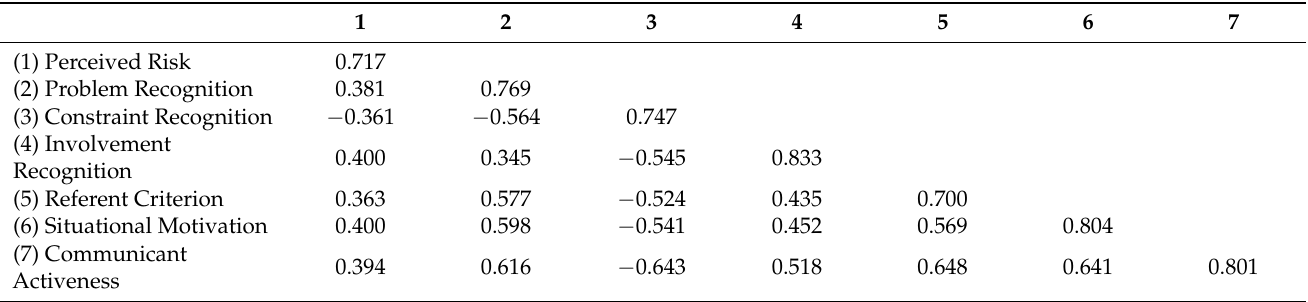
Table 4. Discrimination validity: Pearson correlation and AVE square root